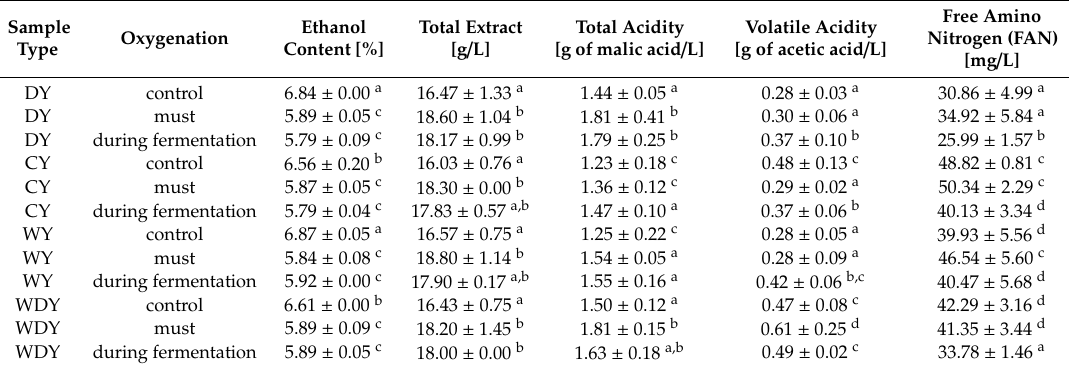
Table 1. Impact of the type of oxygenation on oenological parameters of